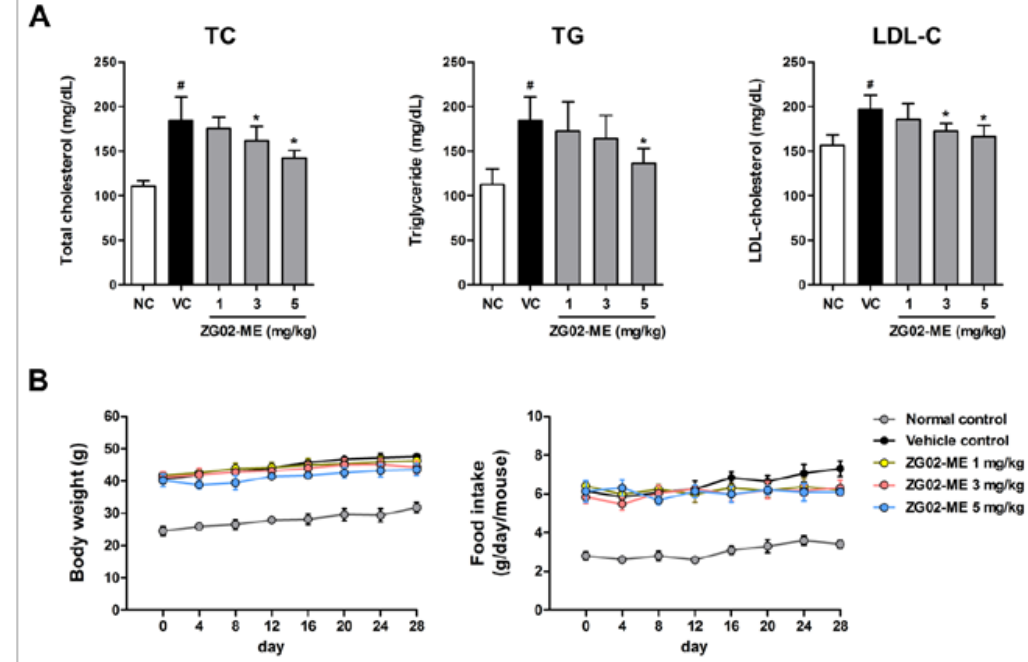
Figure 2. The effects of ZG02-ME administration on blood lipid levels, body weight gain, and food consumption in diabetic-obese ( db / db ) mice. The db / m mice were intragastrically administrated daily with normal saline containing 0.01% DMSO, as the vehicle, for four weeks (normal control). The db / db mice were intragastrically administrated daily with vehicle (vehicle control) or ZG02-ME (1, 3, 5 mg/kg body weight), respectively, for four weeks. ( A ) The total cholesterol (TC), triglyceride (TG), and low-density lipoprotein (LDL-C) levels in blood serum were measured as described in the methods; ( B ) Body weight and food intake were continuously measured from initial to final administration. Data are shown as mean ± SD of ( n = 8). # p < 0.05 vs. normal control, and * p < 0.05 vs. vehicle-treated control as determined by one-way Student’s t -test.